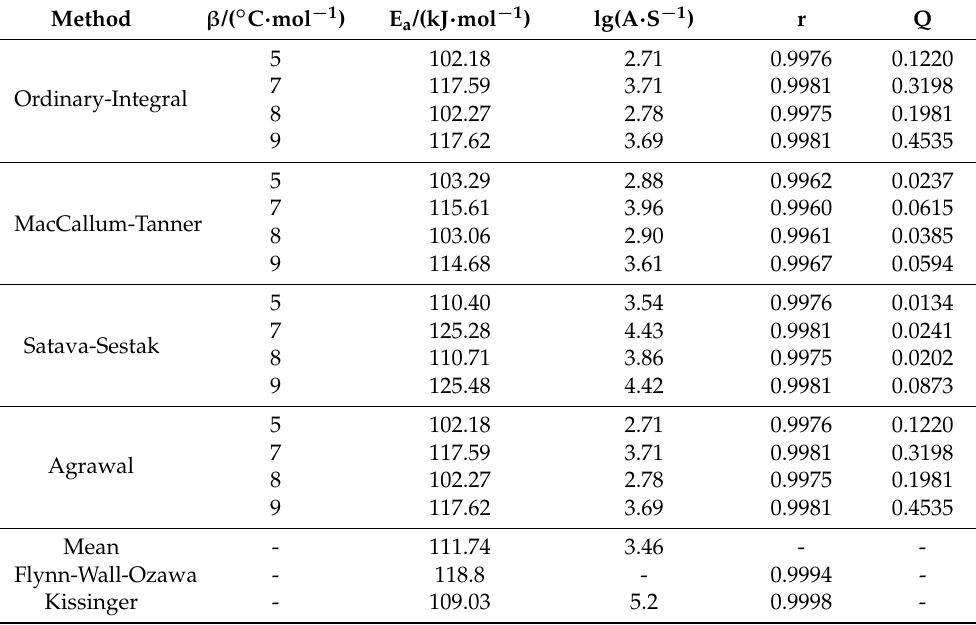
Table 2. Kinetic parameters of the surface nitridation of ANs.